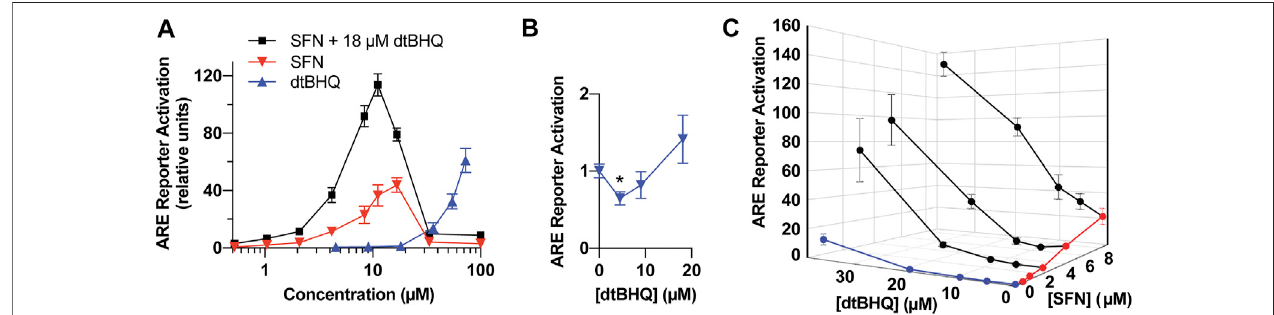
FIGURE 4 | Model system for testing interactions for synergy and antagonism-a dual-luciferase ARE-reporter assay in HaCaT cells. (A) Full dosing curves of sulforaphane(red)anddtBHQ(blue)alone,andthesamesulforaphaneconcentrationswithaco-treatmentof18 µMdtBHQ(black). (B) ThedatafromthelowestdtBHQ concentrationsareplottedtoshowthesuppressionofthereporterexpressionat4 µMdtBHQ(* p -value (cid:1) 0.006). (C) Effectsofvariouscombinationsofsulforaphaneand dtBHQ. Combination treatment data are shown in black. The experiments were performed in quadruplicate, and the data are presented as mean ±